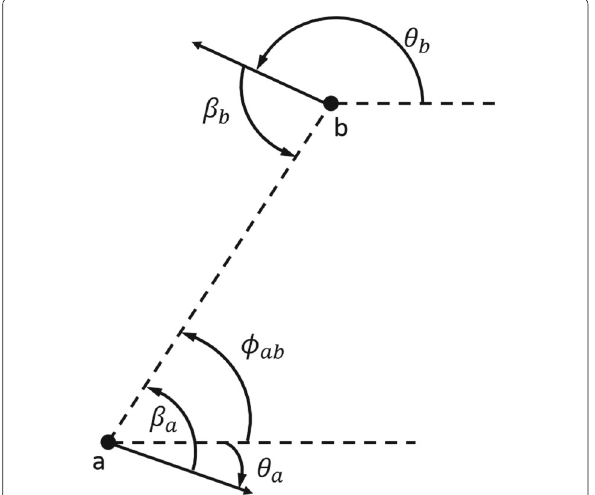
Fig. 3 The relevant angles in a minutia pair. The β a and β b are rotation invariant. The φ ab is sensitive to image